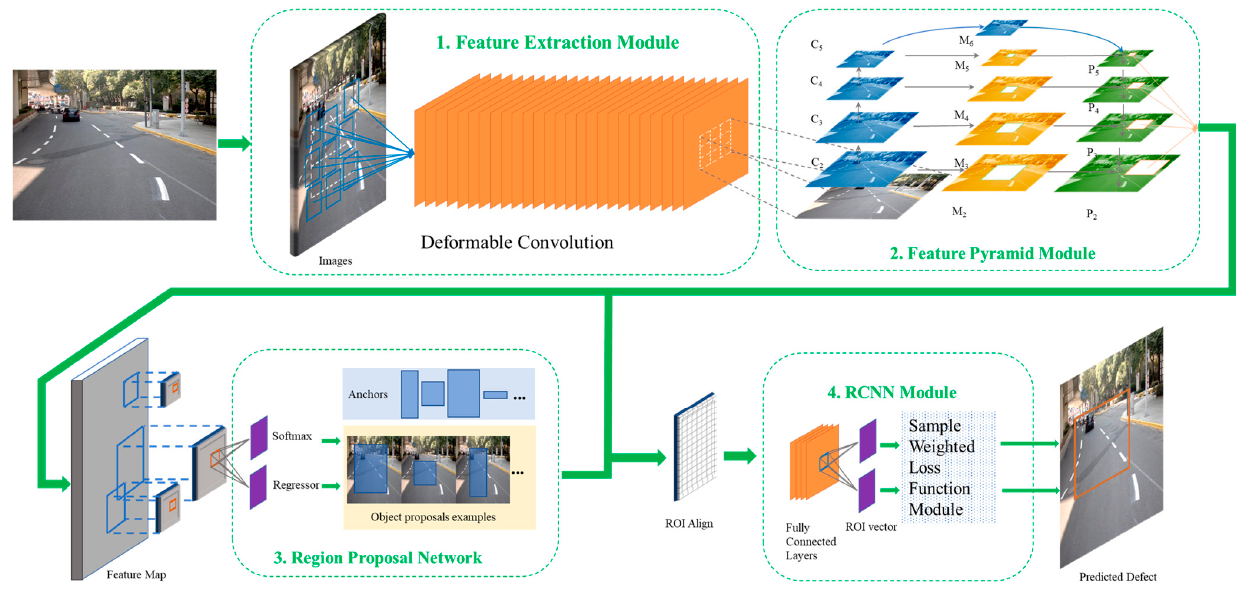
Figure 2. The flow of DASNet proposed in this paper includes feature extraction module, feature pyramid module and sample weighted loss